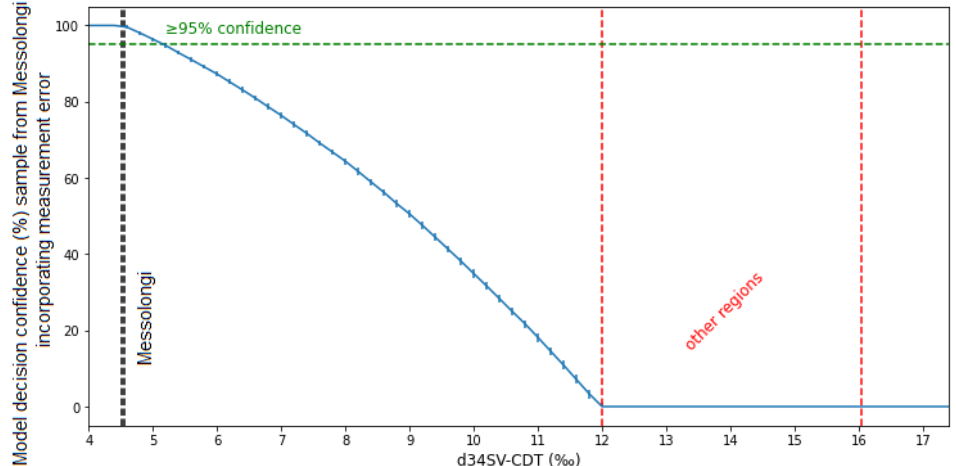
Figure 7. Distribution of standard deviation of measurement error.